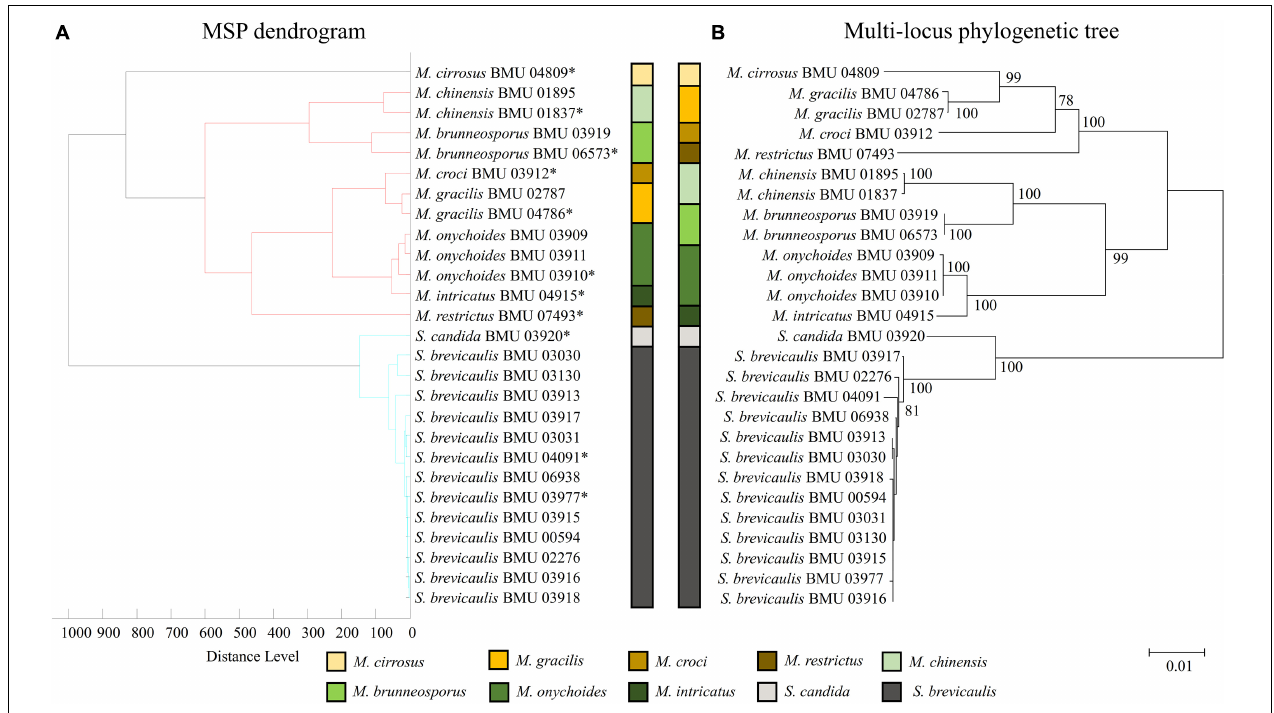
FIGURE 7 | (A) Main spectrum profile dendrogram of 27 Scopulariopsis and Microascus isolates based on MALDI-TOF MS analysis; (B) molecular phylogenetic tree generated by the NJ method from the combined ITS, LSU, TUB , and EF1- α sequences of 27 Scopulariopsis and Microascus